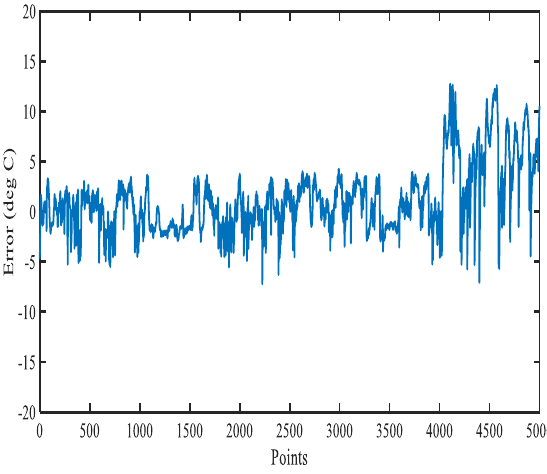
Figure 19. Residual temperature of the gearbox bearing.